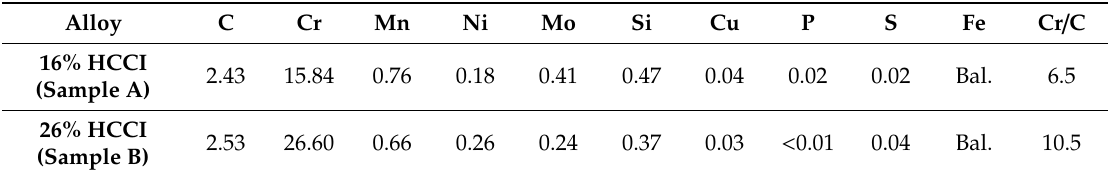
Table 1. Bulk chemical composition (in wt. %) of the samples measured by optical emission spectroscopy. HCCI: high chromium cast irons.